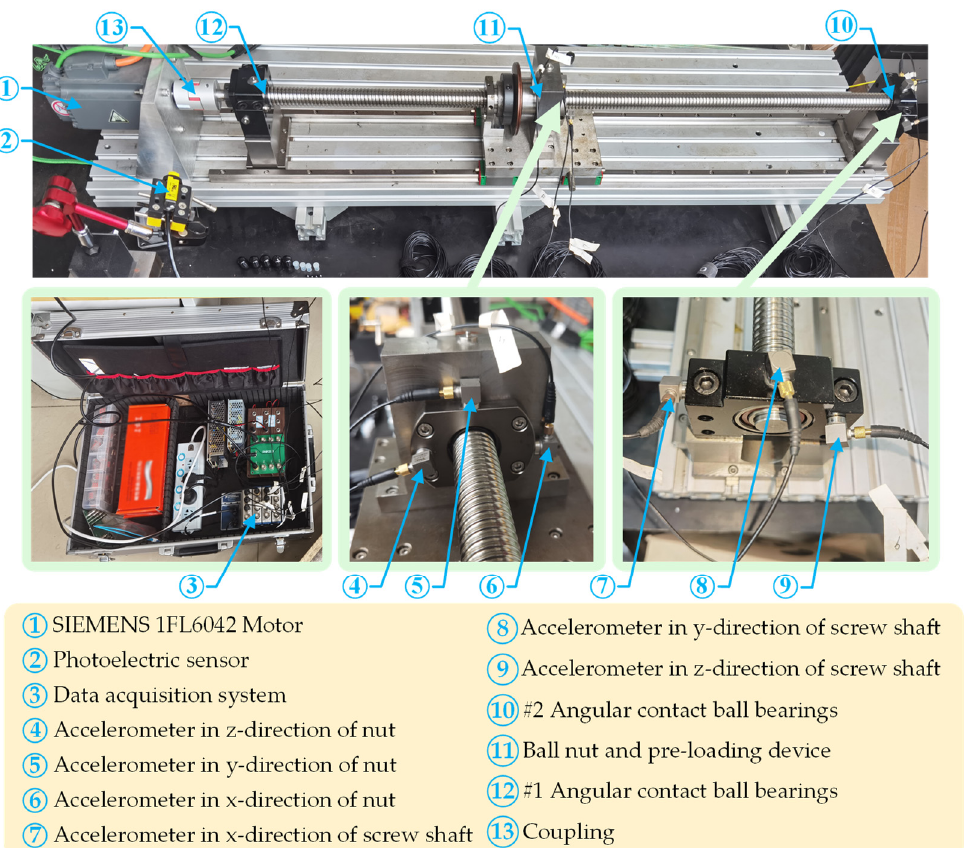
Figure 15. Main components of the EMA test stand. The faulty nut used in the test stand is machined from a normal sfv2505 nut. A 1 mm gap is cut in the y direction of the nut by the wire cutting method to simulate the spall generated during EMA operation. The faulty nut is shown in Figure 16.